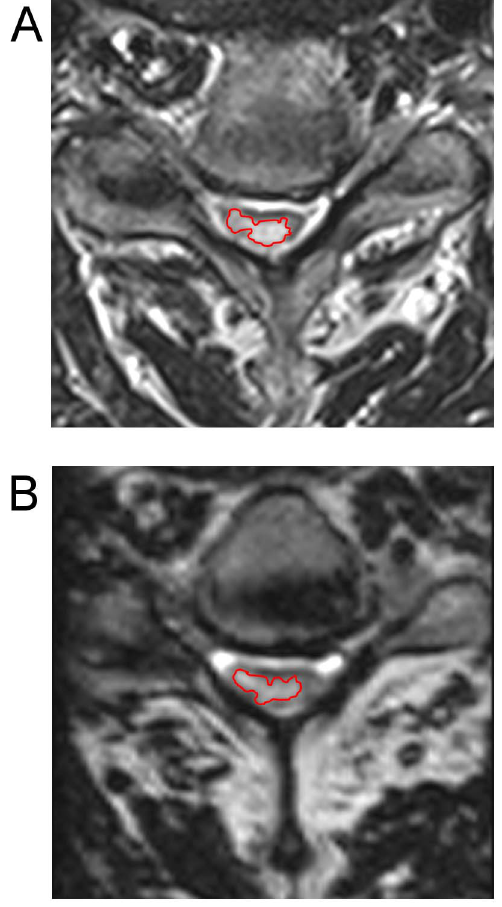
Figure 1. Example of cord lesion in the cervical spine. Images of the cervical spine in a representative patient demonstrated a region of abnormal cord signal both on (a) 2D-FSE sequences and (b) 3D-FSE sequences. The lesion was qualitatively similar on both sequences and approximately the same size. However, it appeared slightly less hyperintense on 3D-FSE images than on 2D-FSE images. A red outline illustrates the typical placement of the ROIs used for analysis.